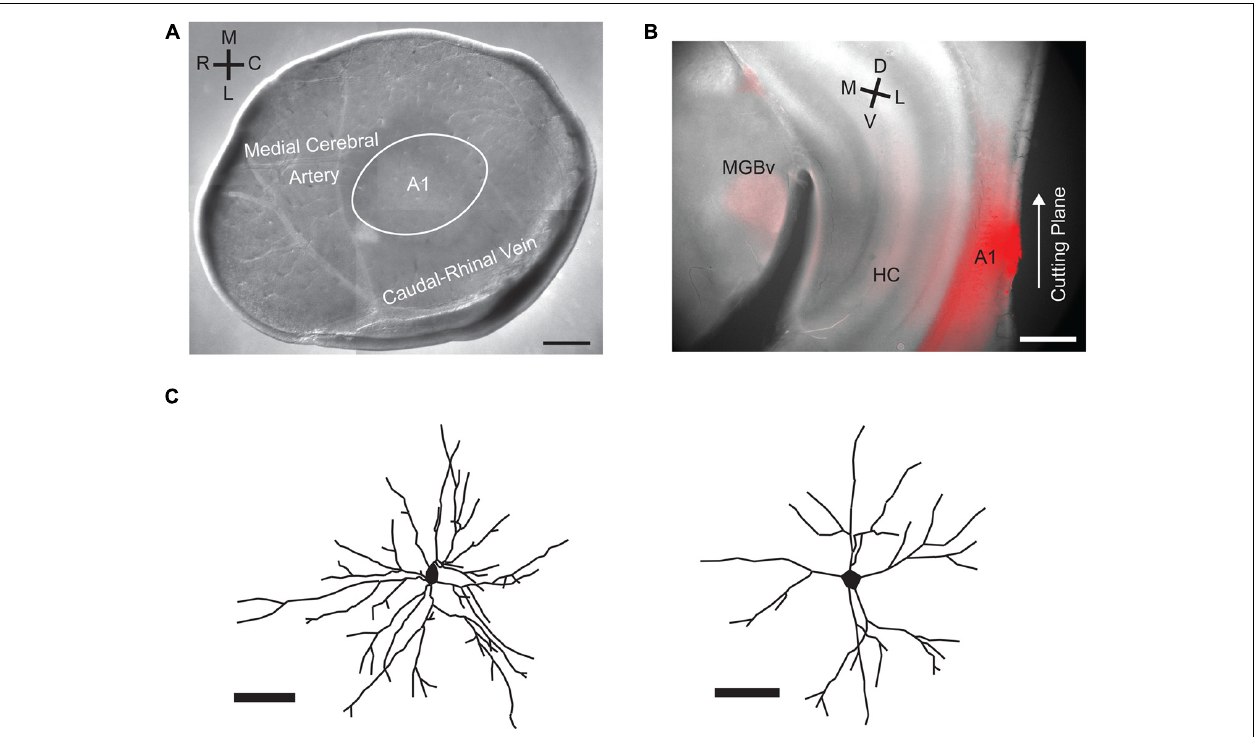
FIGURE 1 |A1 tangential slice preparation and biocytin stains of basal dendritic arbors. (A) DIC image of the A1 tangential slice with the vasculature preserved. Labels indicate approximate position of A1 relative to the vasculature. (B) Retrograde labeling of auditory thalamus (MGN) after